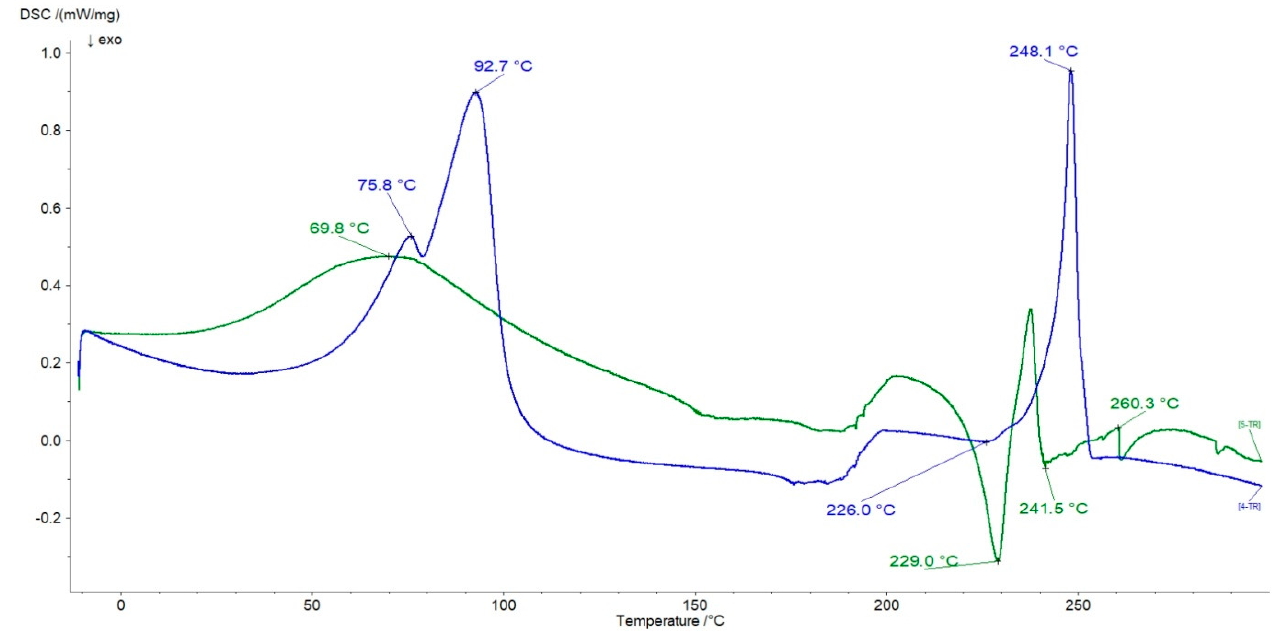
Figure 13. The thermograms of the physical mixture of HA + N (green line) and the formulation F7 (blue line).